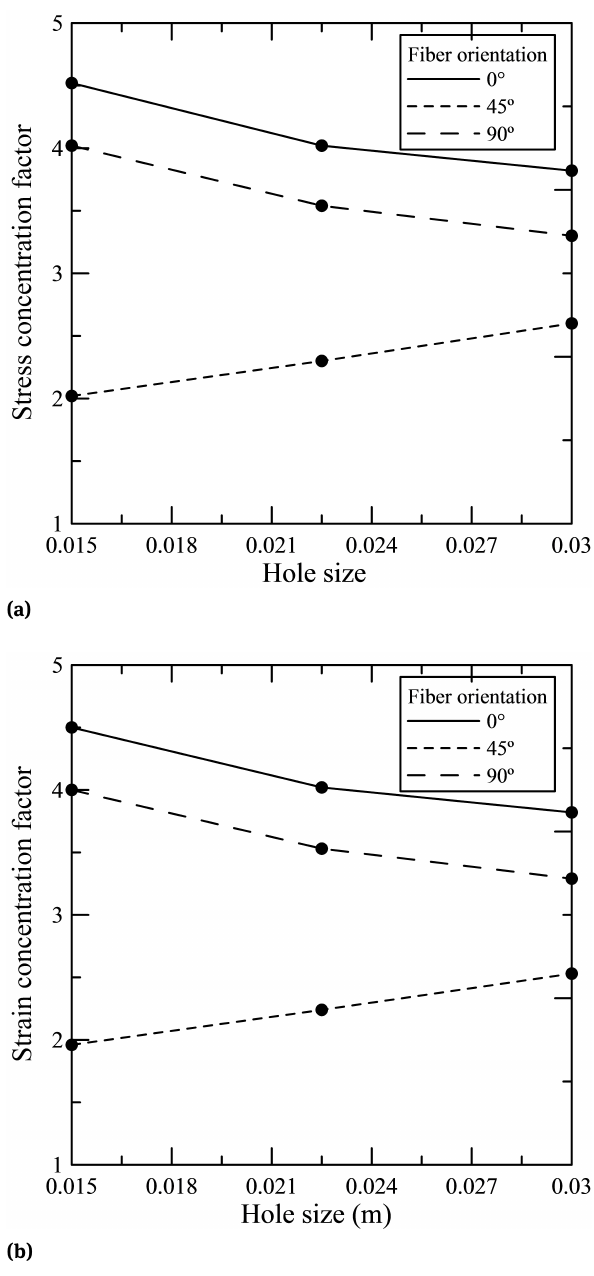
Figure 15: Effect of hole size and fiber orientations on: (a) stress concentration factor and (b) strain concentration factor